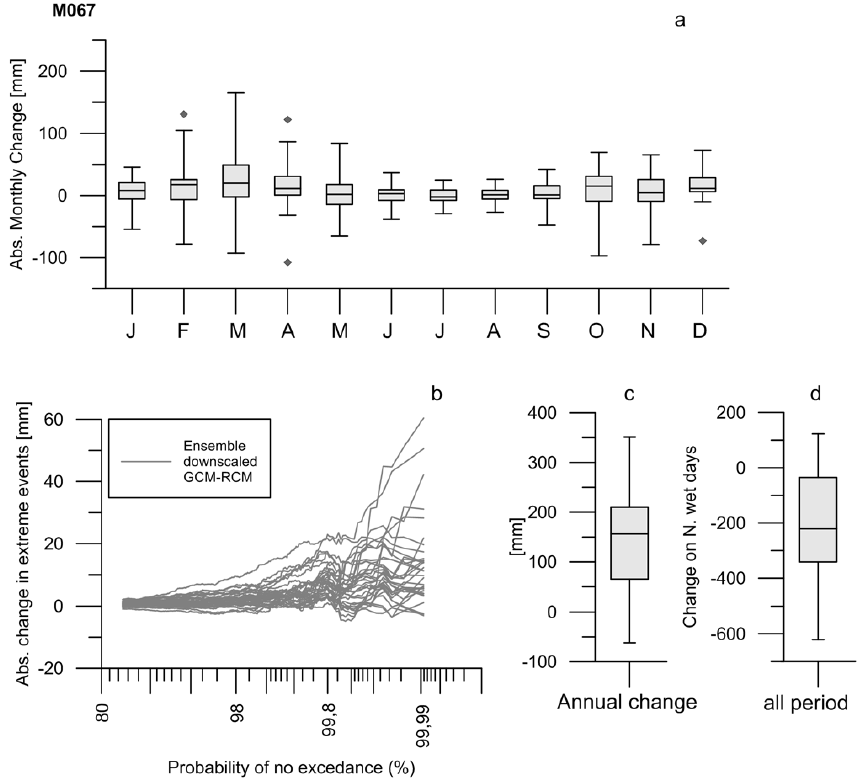
Fig. 4. Example of the impact indicators for downscaled rainfall change in site M065 (scenario A2). (a) Change of monthly rainfall depths, (b) change of rainfall depths at extreme quantiles, (c) change of annual rainfall depths and (d) change in the number of wet days.